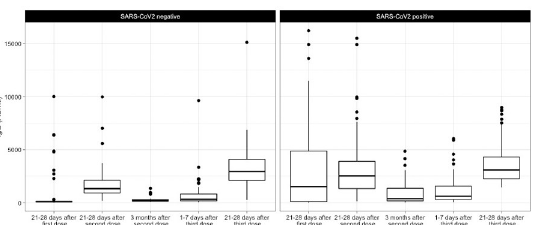
Fig 1. Boxplot scheme of the quantitative SARS-CoV-2 spike 1–2 IgG antibody titers according to SARS-CoV-2 history.